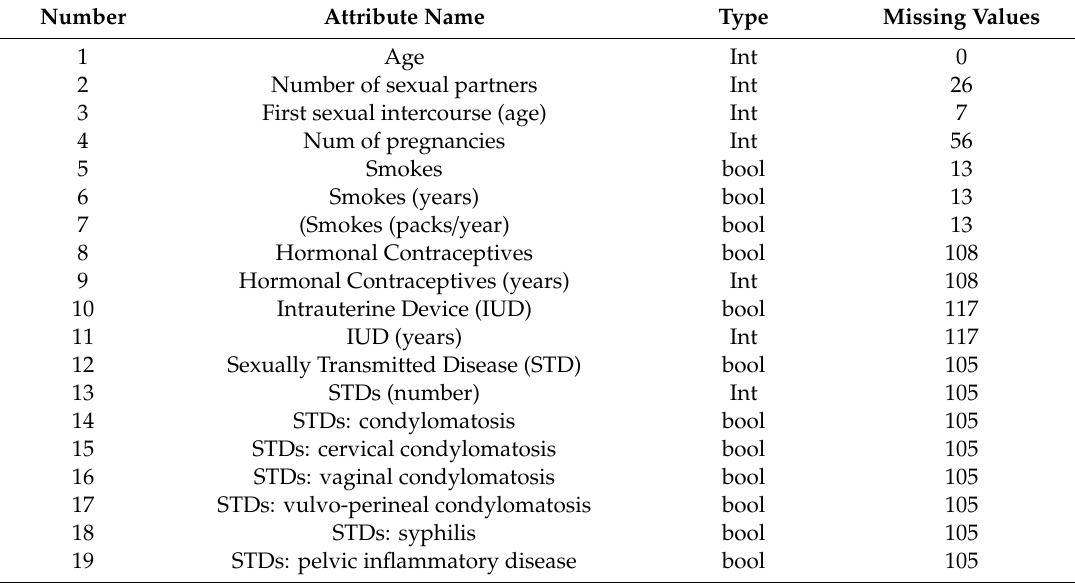
Table 1. Dataset features, number of entries, and missing